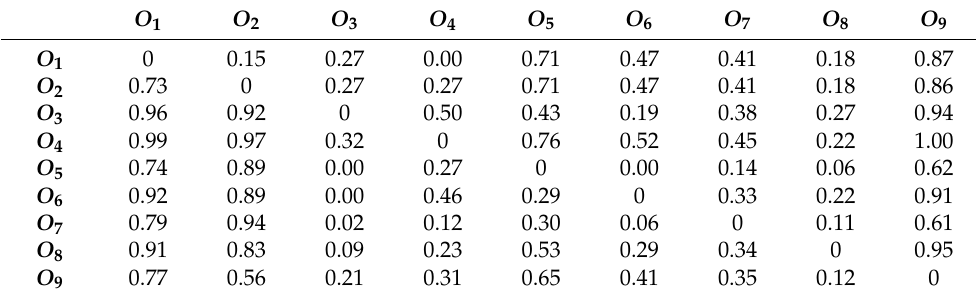
Table 21. Discordance matrix for traditional ELECTRE II.